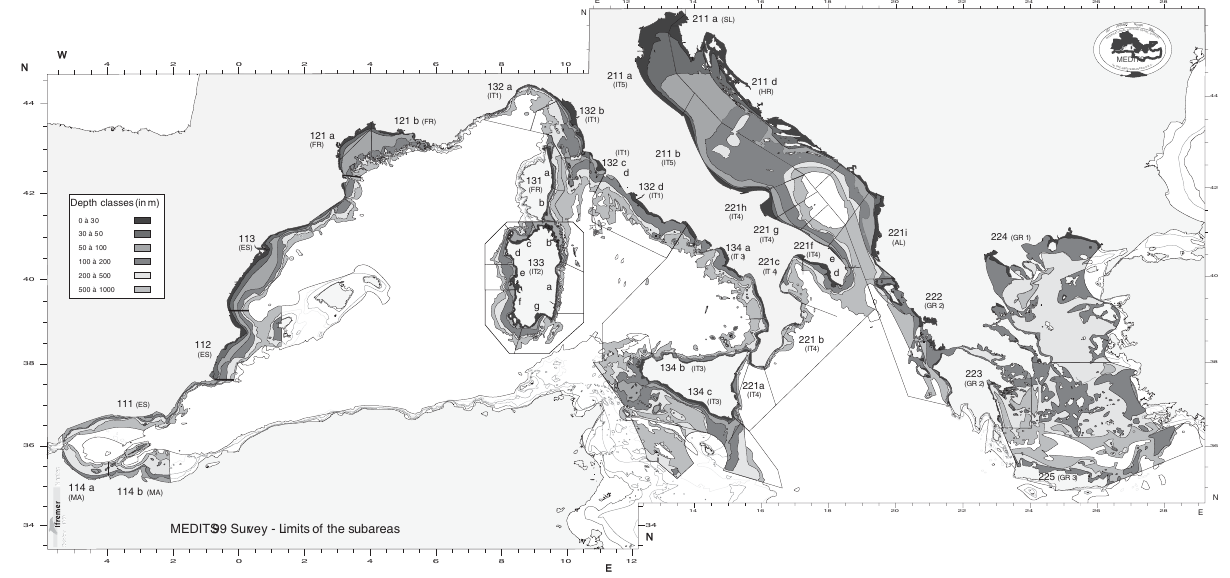
Fig. 1.- Study area of the MEDITS trawl surveys. Limits of the sampling strata (MEDITS 1999).